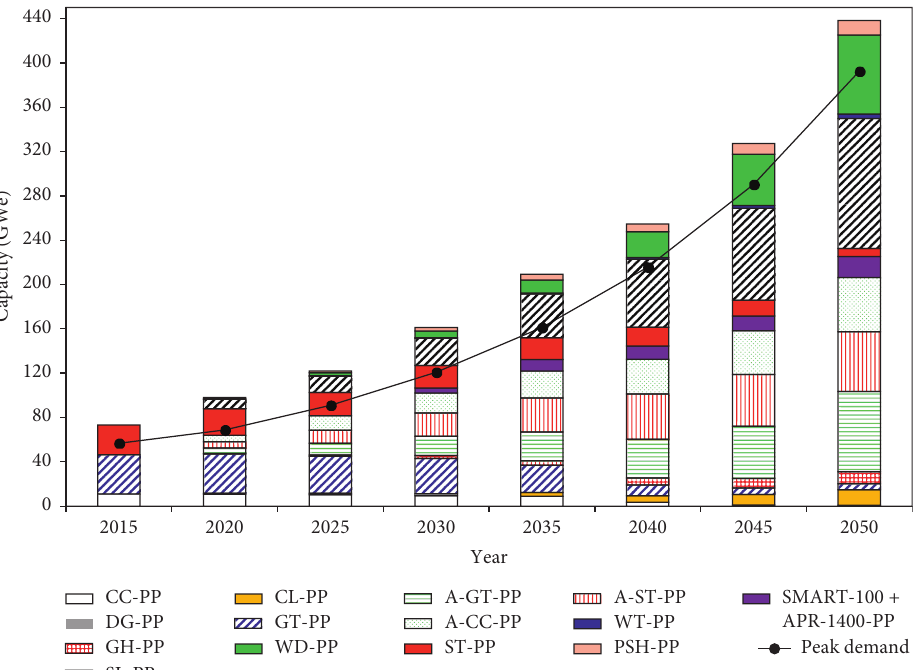
Figure 15: Simulation results from MESSAGE tool for Subscenario